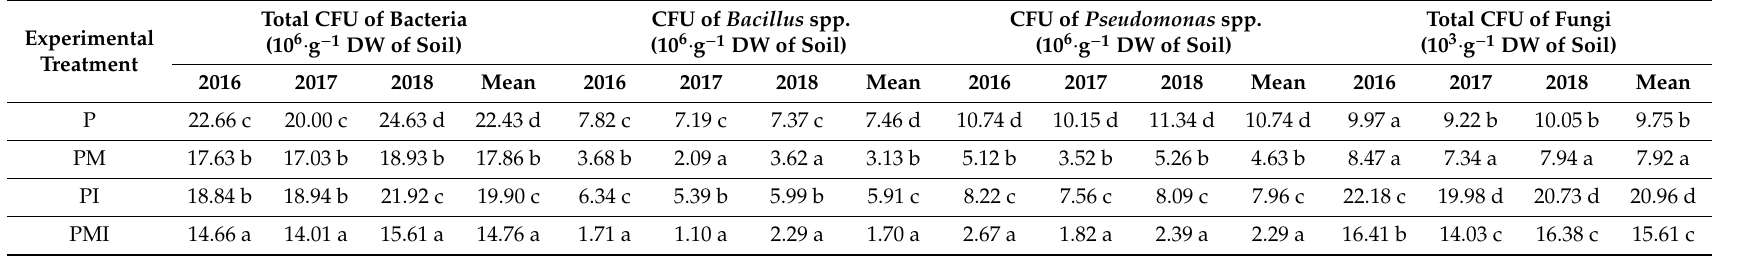
Table 2. Number of bacteria and fungi isolated from the soil in the individual experimental